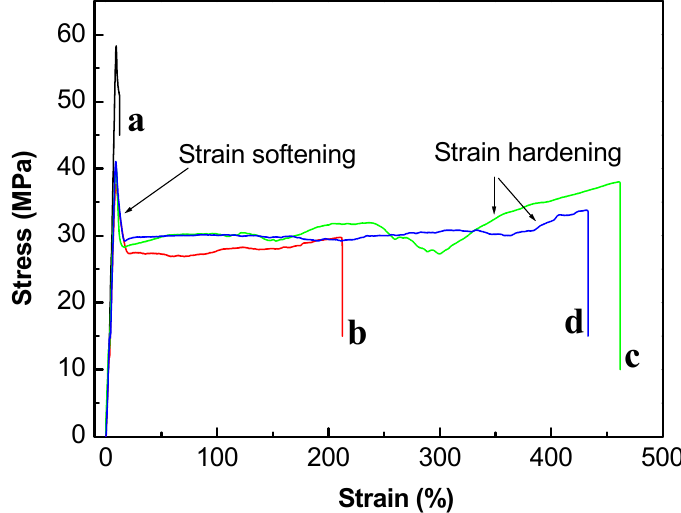
2. Stress–strain curves of ( a ) PLA; ( b ) (80/20, w / w